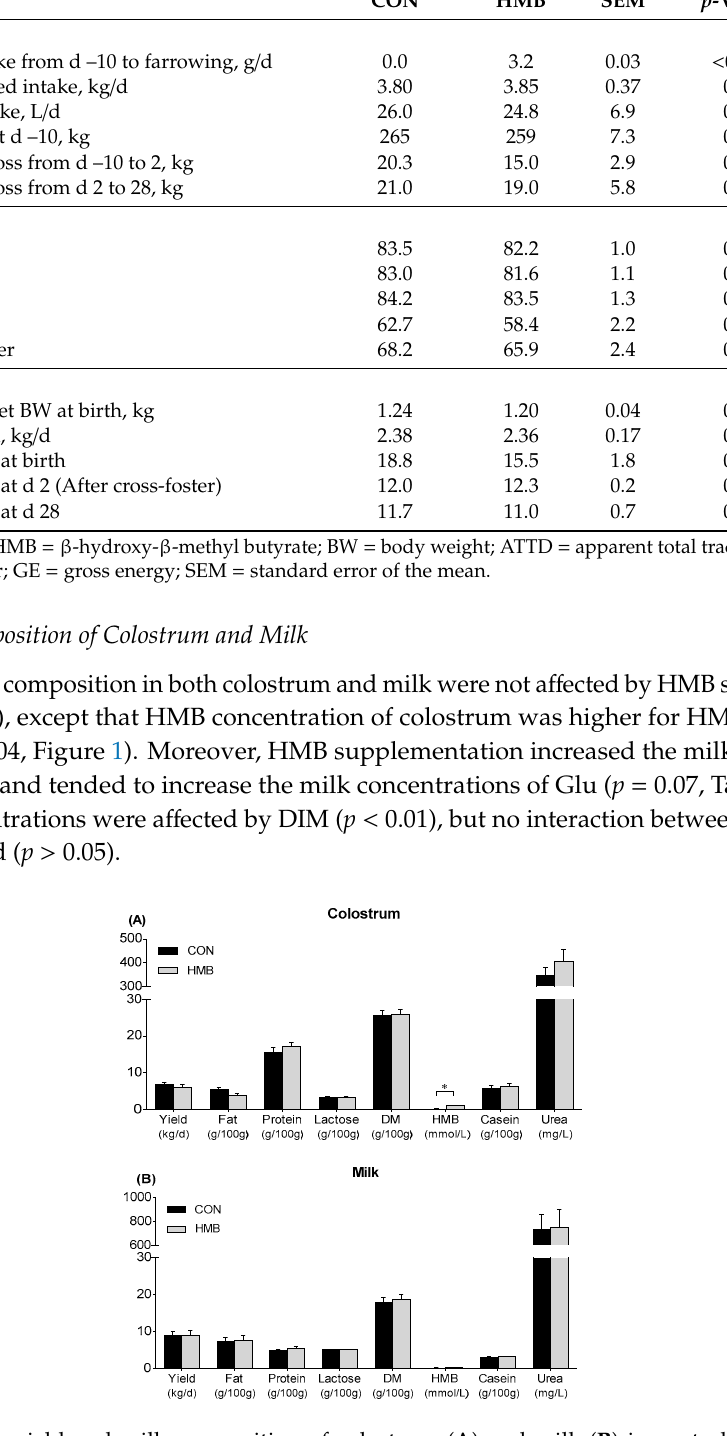
Figure 1. Milk yield and milk composition of colostrum ( A ) and milk ( B ) in control (CON) and HMB-supplemented (HMB) sows. Data are expressed as the mean ± SEM. Sows were regarded as the experimental units, n = 4 for each group. The differences between groups were indicated by an asterisk ( p < 0.05). CON = control; HMB = β -hydroxy- β -methyl butyrate; DM = dry matter. Table 2. Milk amino acids compositions of control (CON) and HMB-supplemented (HMB) sows during early and peak lactation.